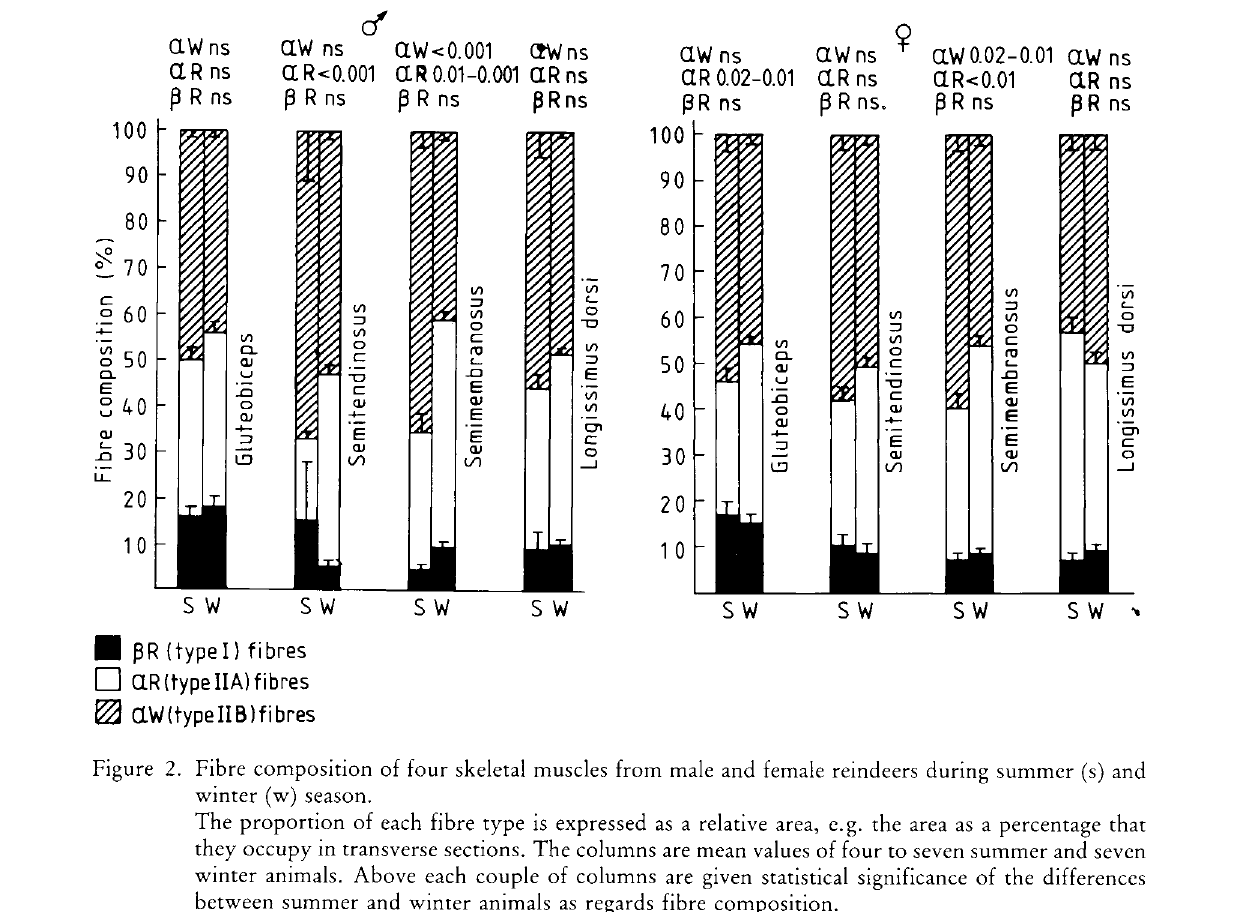
Figure 2. Fibre composition of four skeletal muscles from male and female reindeers during summer (s) and winter (w) season.